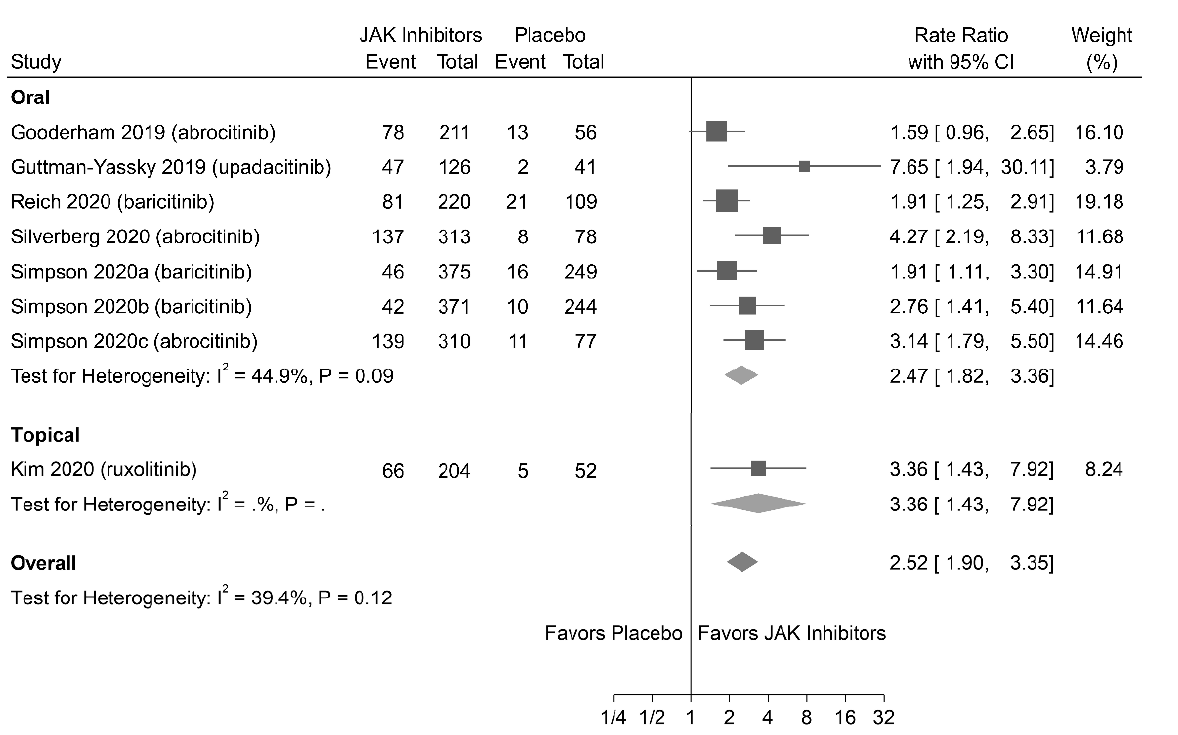
Figure 3. Association of Janus kinase (JAK) inhibitors versus placebo achieving at least a four-point improvement in pruritus Numerical Rating Scale (NRS) score from the baseline (pruritus-NRS response). CI, confidence interval.